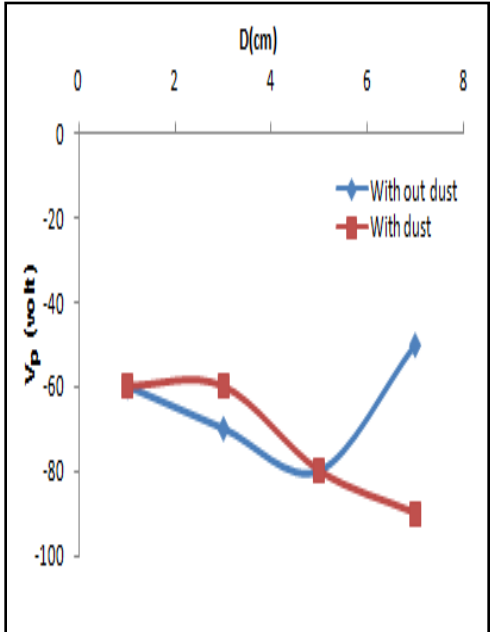
Fig.7: The plasma potential with Diameter position at different distances of the probe.